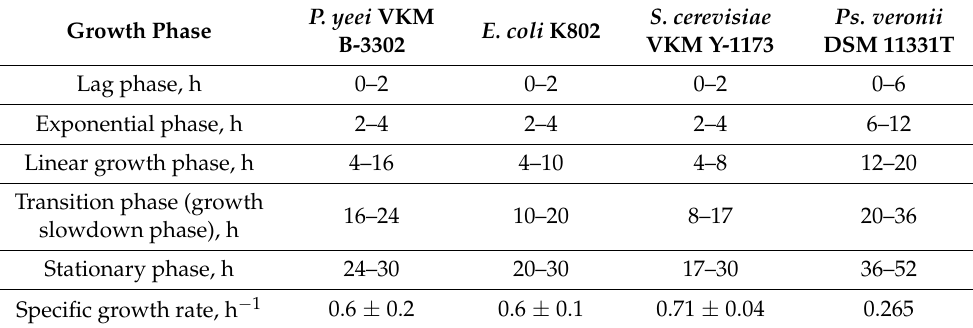
Table 3. Parameters of microbial growth curves.